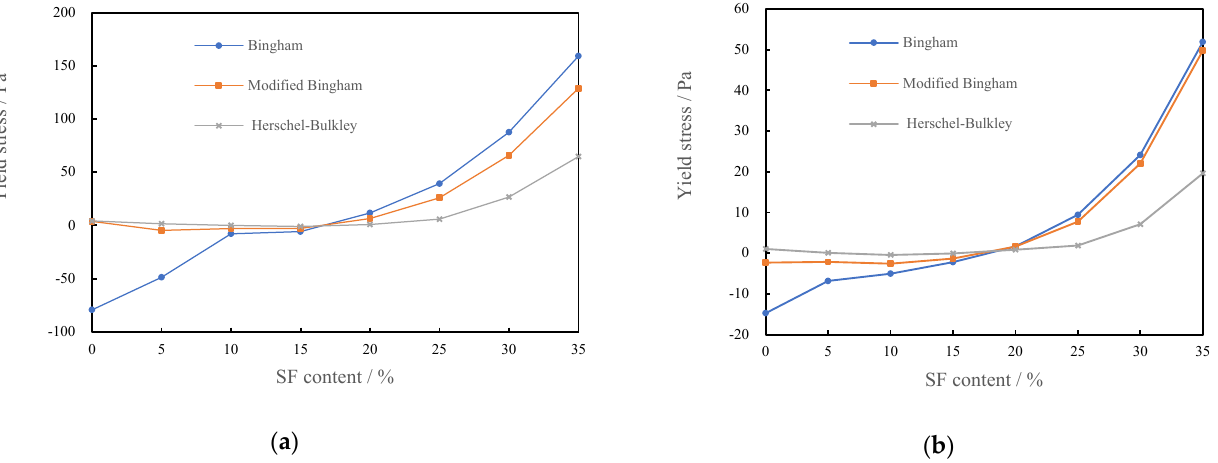
Figure 6. The relationship between yield stress and silica fume content of CSHWM, ( a ) W/B = 0.19 , ( b ) W/B = 0.23 .